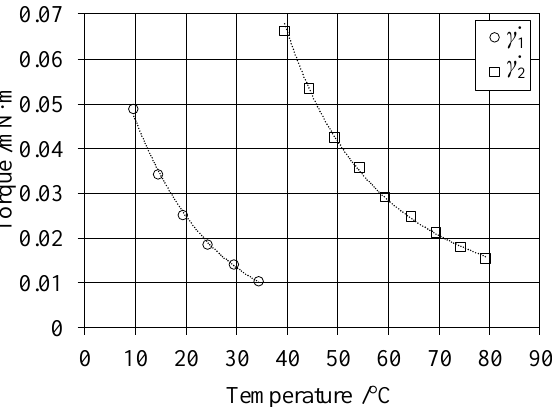
Fig. 4. Dependence of the spindle torque T on the oil temperature t O , the shear rates are γ̇ 1 = 13.03 s -1 and γ̇ 2 = 102.37 s -1 .